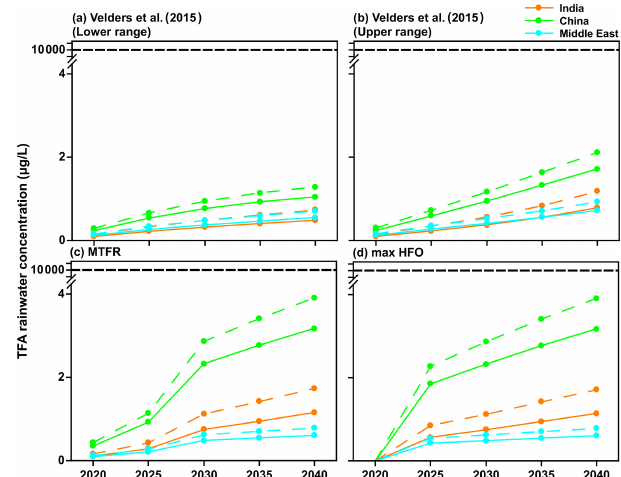
Figure 10. Mean TFA rainwater concentration in four scenarios for 2020 to 2040 for India, China, and the Middle East domains cal- culated using GEOS-Chem (solid lines) and WRF-Chem (dashed lines). The NOEC is denoted above, and it is 2 orders of magnitude larger than calculated TFA concentrations for any of the